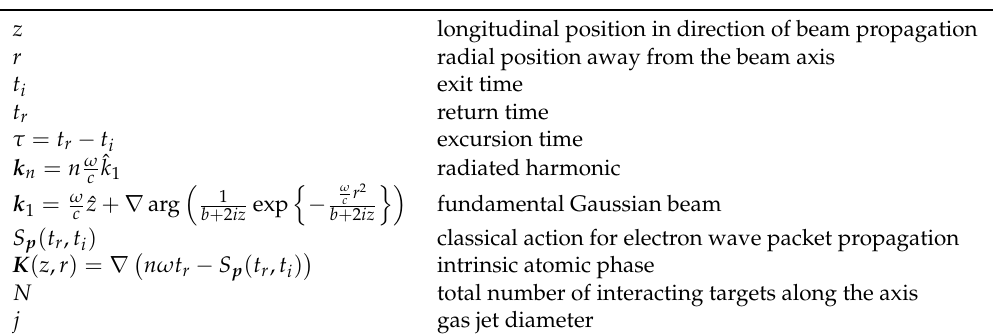
Table 1. Quantities in phase